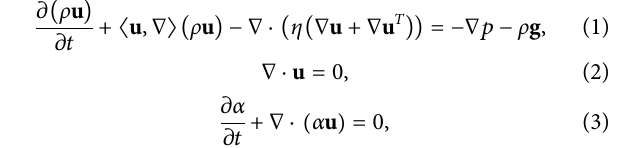
Frontiers in Earth Science |